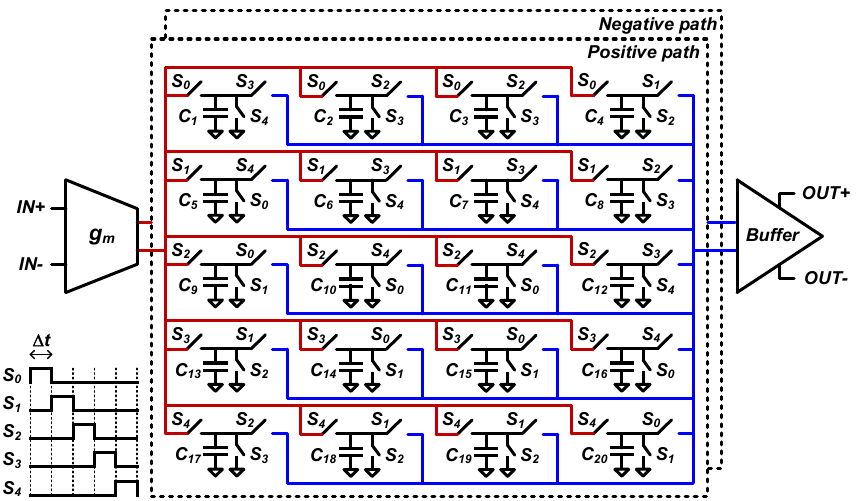
Figure 2. Conventional architecture. Red lines indicate charge sampling paths, and blue lines indi ‐ cate read ‐ out paths.